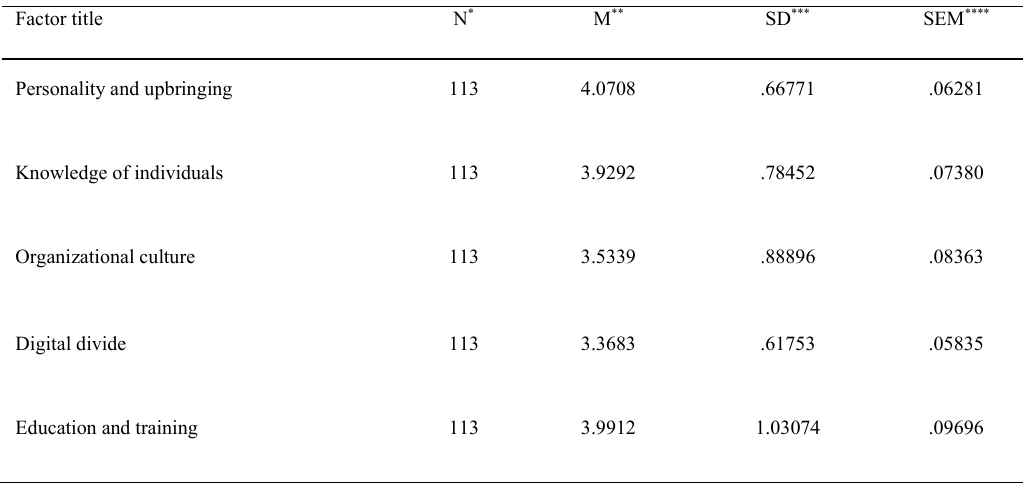
Table 2: Statistical results of